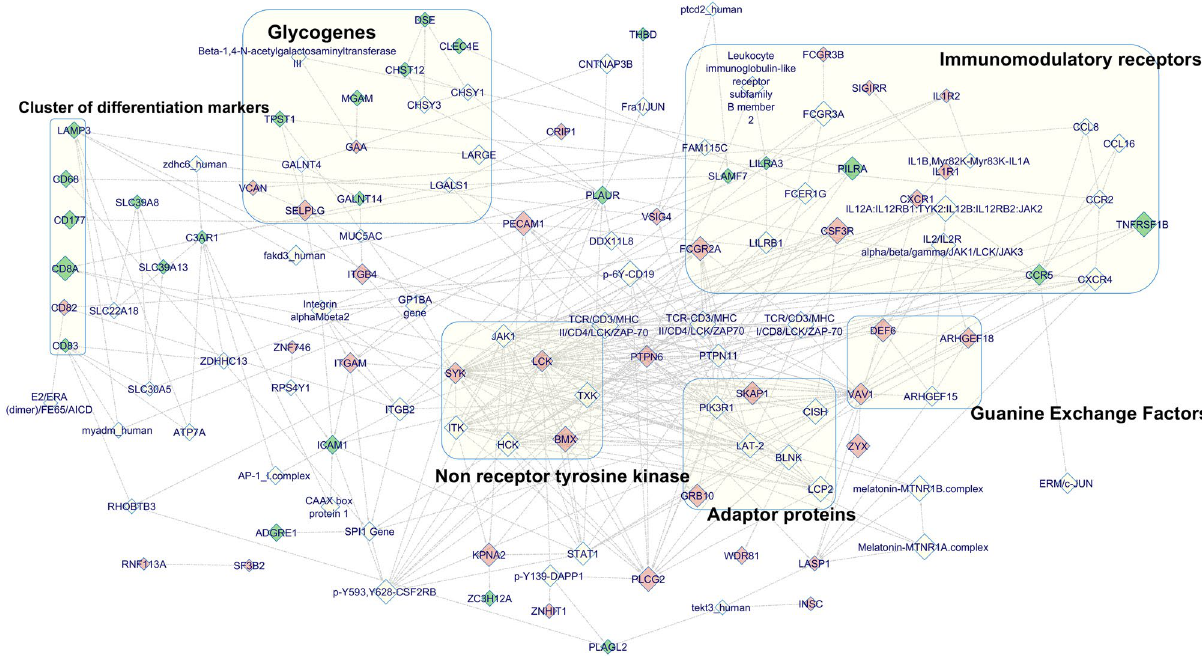
Figure 2. Network visualization of the integrated network module of both upregulated and downregulated genes identified from the blood samples of MDD patients. The interaction network is generated using the CPDB induced network modules by inputting the gene subsets from the top ranking gene family clusters along with the glycogenes. The compact subnetwork is created by applying a z-score threshold of 20 in the CPDB user interface. Exported network model from the CPDB is processed in the Cytoscape visualization tool using GeneMANIA Force Directed Layout and the entities are manually aligned. Colours of the nodes are adjusted based on gene expression data wherein wine red colour represents upregulated genes and dark green represents the downregulated genes. Major network modules with maximum representation of the DEGs are highlighted in the graph using a light yellow